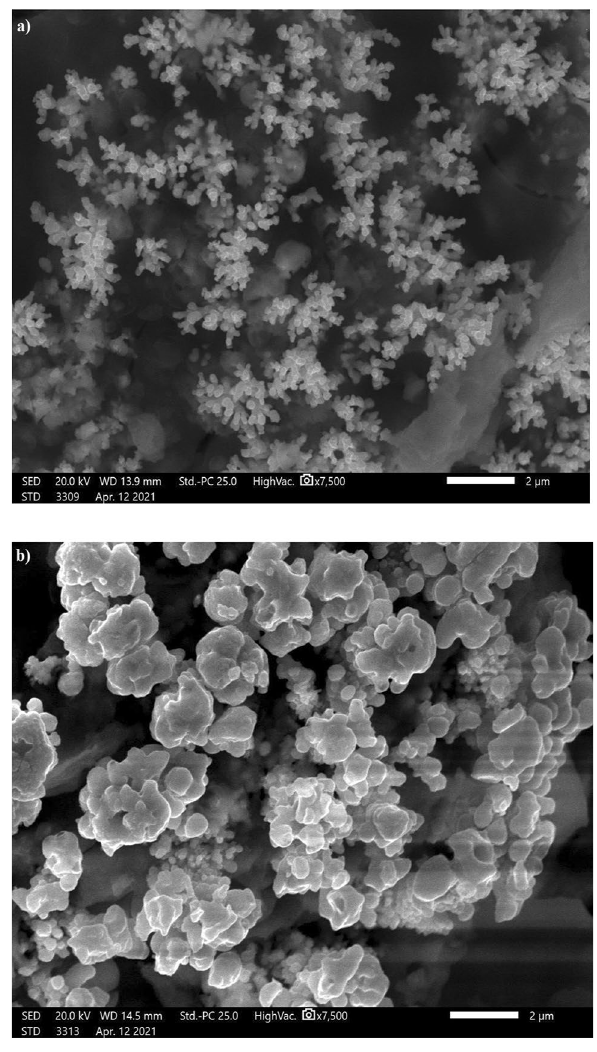
Figure 1. SEM images of copper grafted by ( a ) Ni-MA and ( b )